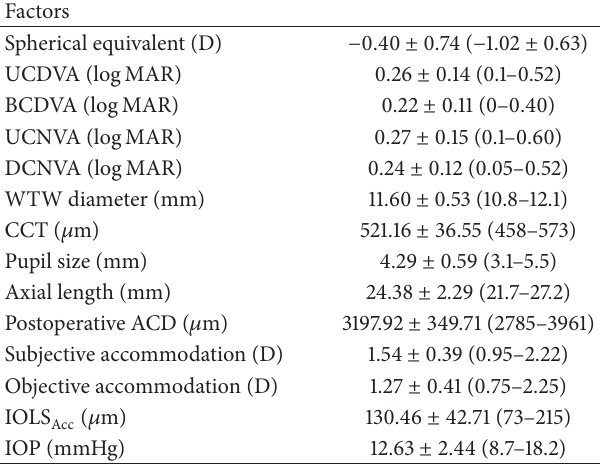
Table 2: Results of ocular factors at 3 months